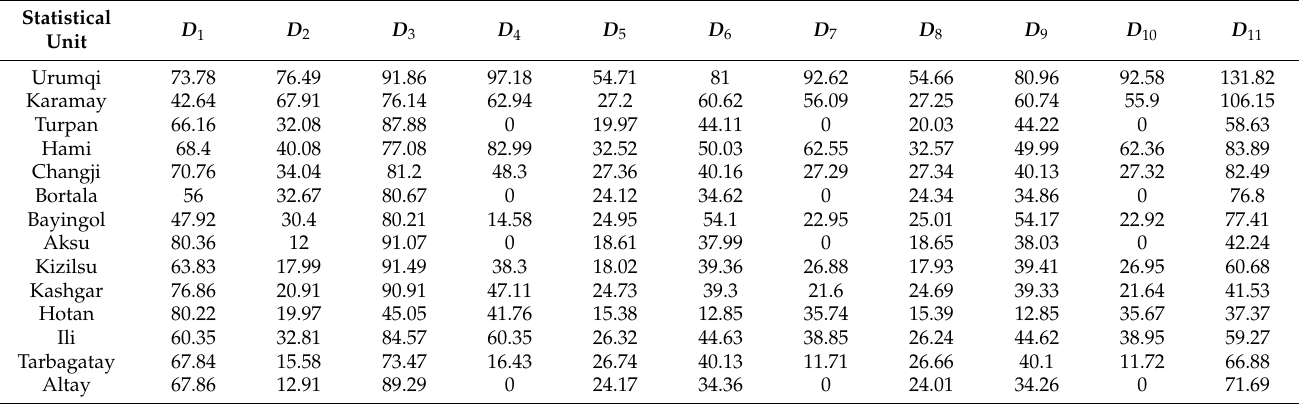
Table A2. The coverage of residential areas, administrative villages, population, health risk popula- tion, and the proportion of medical staff within the service radius of medical institutions in various administrative regions of Xinjiang.